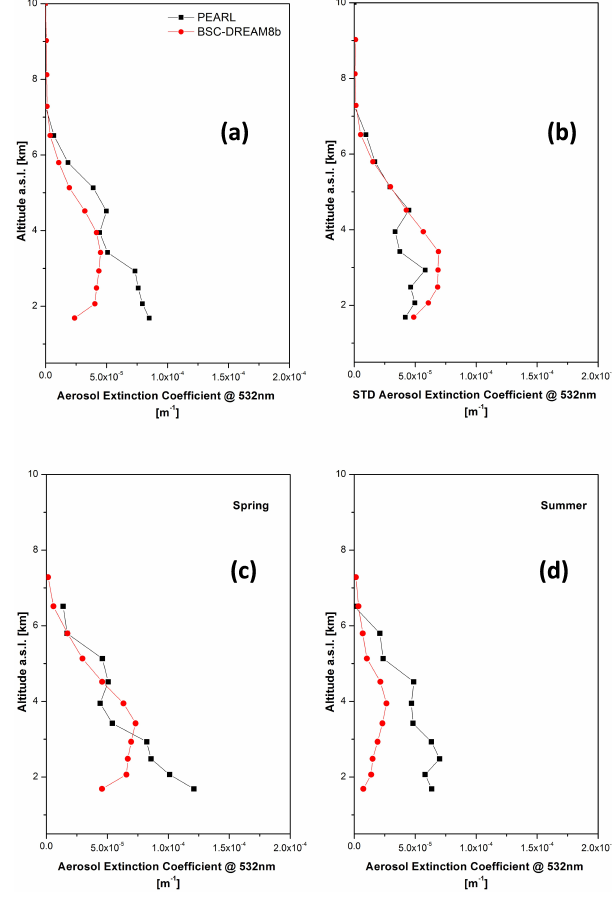
Figure 5. Mean aerosol extinction profiles (a) and related standard deviation profiles (b) calculated for lidar and the model within the identified dust layer. Mean aerosol extinction profiles for spring ( (c) , 29 profiles) and summer ( (d) , 21 profiles) cases are reported at the